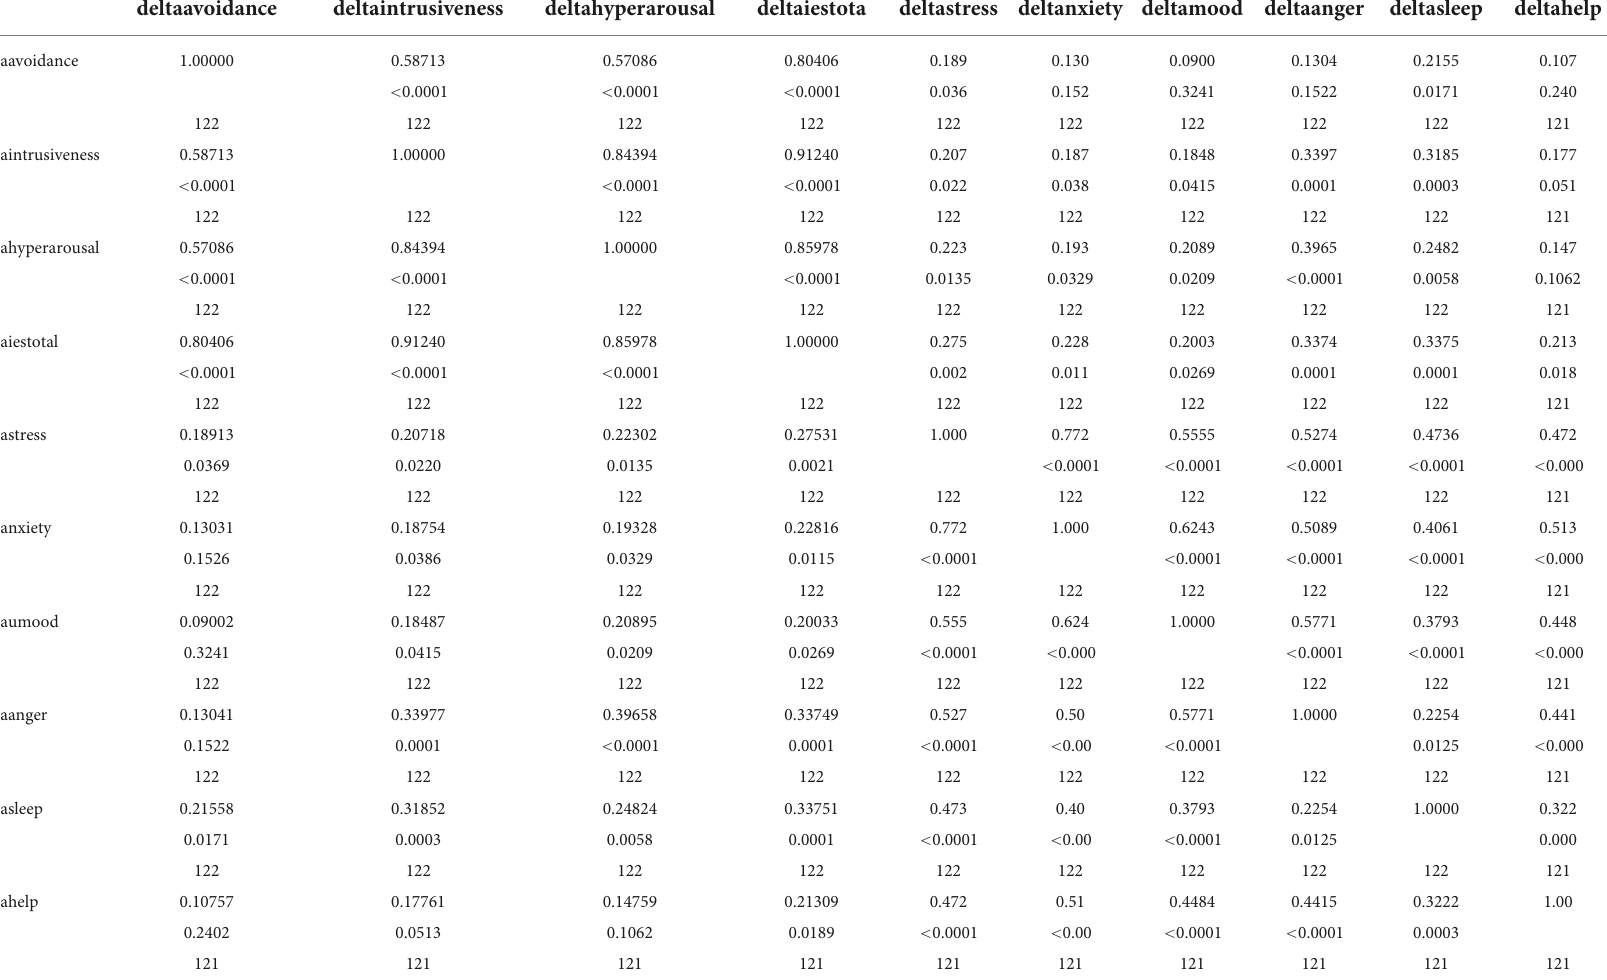
TABLE 4 Spearman correlation